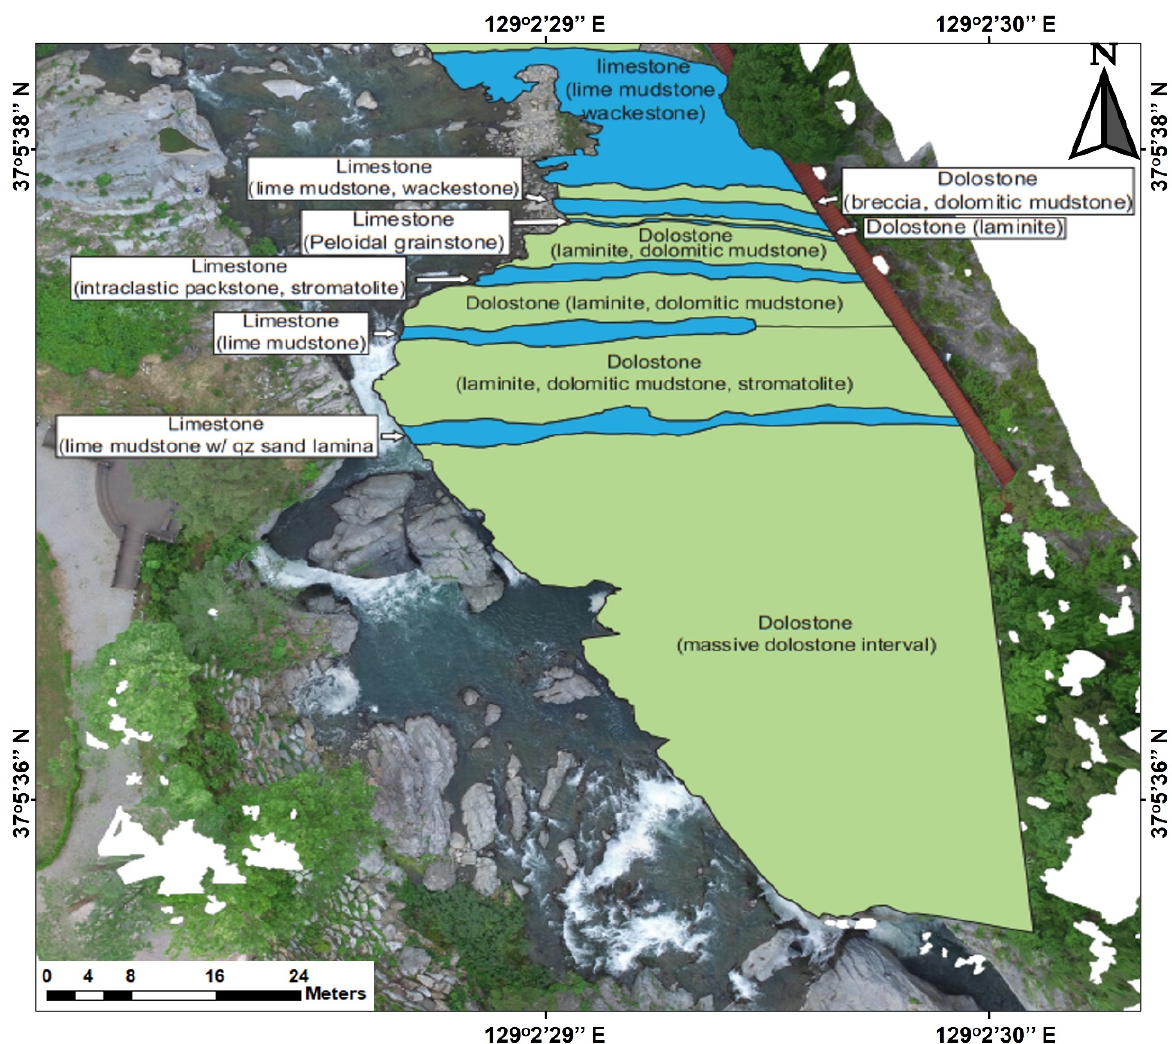
Figure 3. Field survey map overlaid on the ortho-rectified image for validation of the classification.